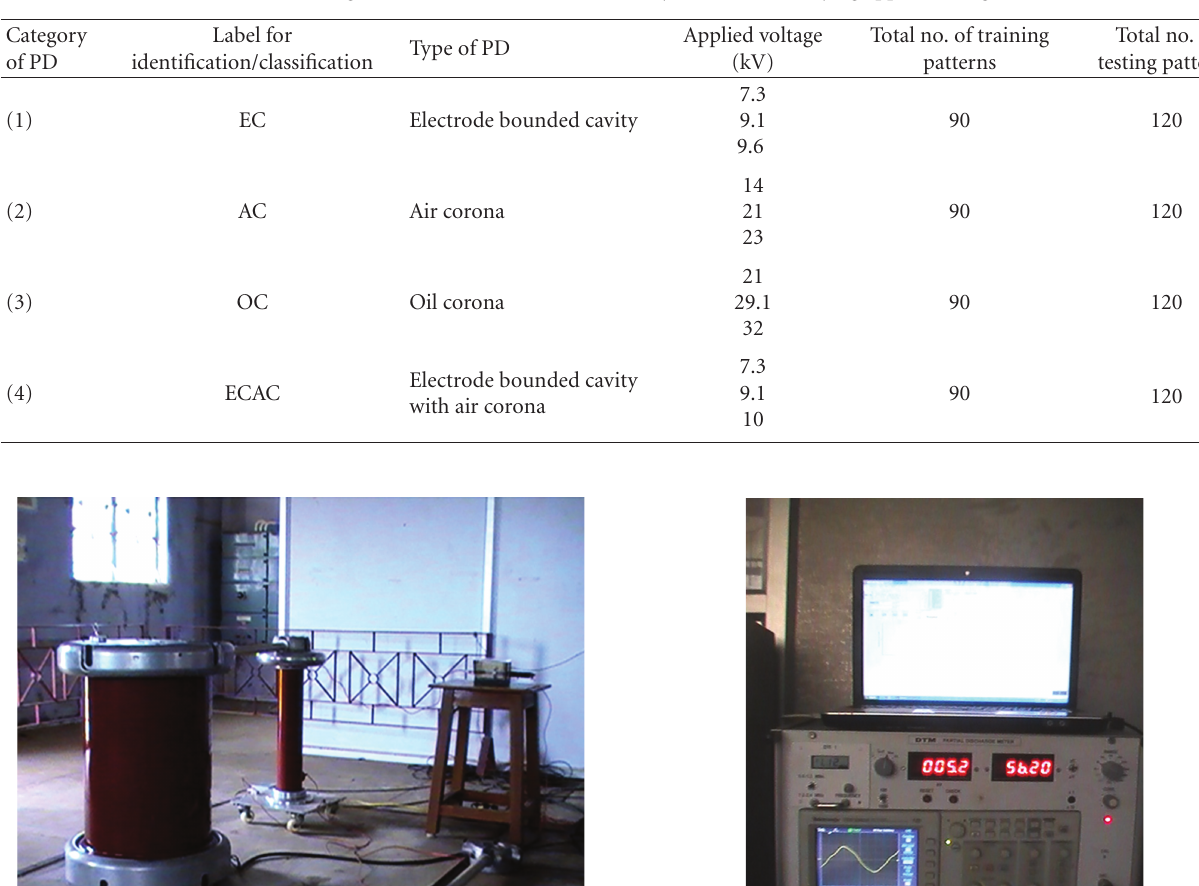
Table 2: Large dataset PD database of laboratory models with varying applied voltages.